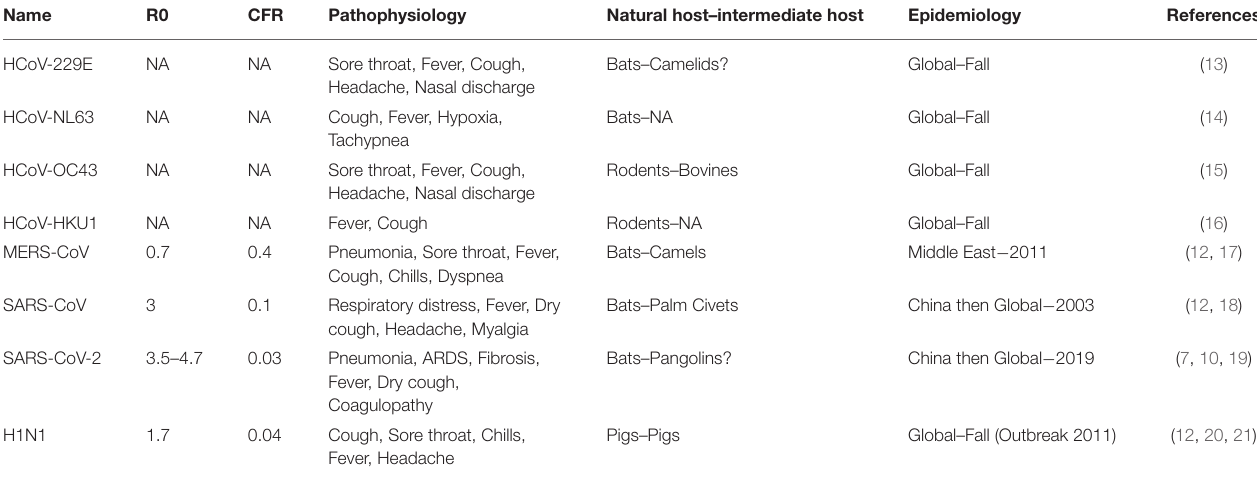
TABLE 1 | Human pathogenic